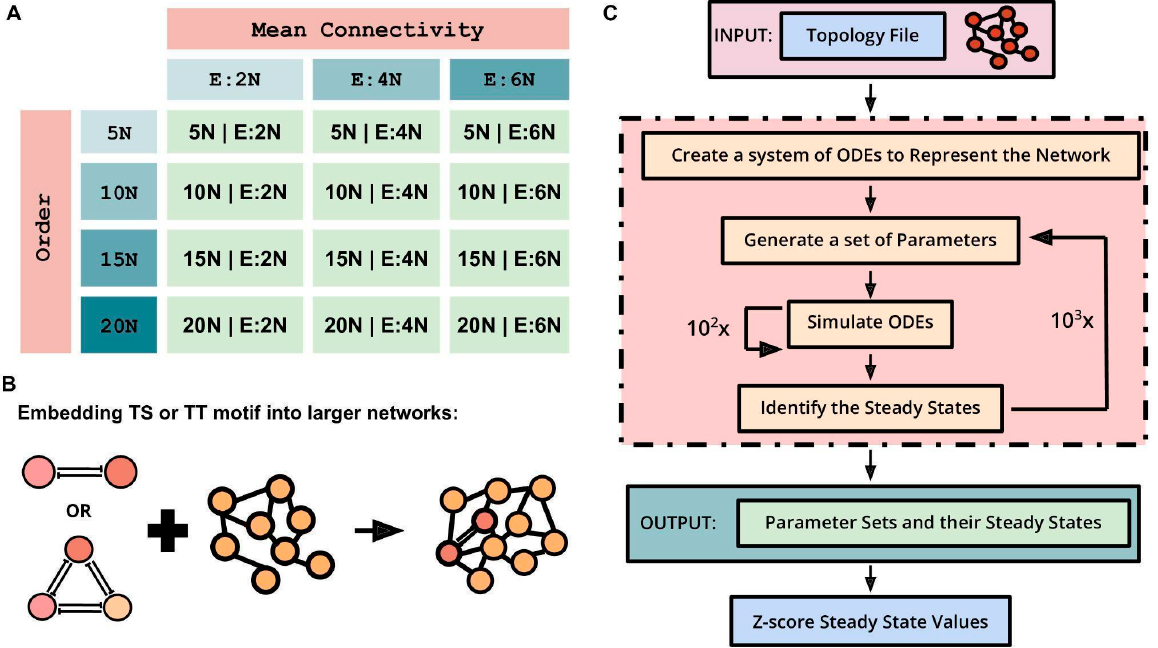
Figure 2. Schematic of the pipeline used to generate, simulate and analyze the motifs embedded in random networks. ( A ) Table showing the twelve types of networks which were created as combinations of three mean connectivity and four network orders. ( B ) Schematic showing the process of embedding the motifs into the created networks. ( C ) Simulation pipeline of RACIPE used to obtain the steady state values for these larger networks containing embedded TS or TT, for further analysis.